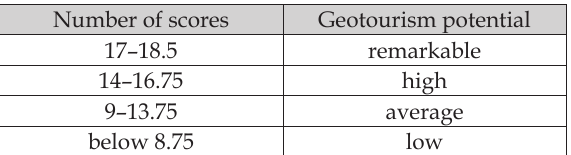
table 4. Final ranking of geotourism potential based upon the analysis of the selected geosites in the Drawskie Lake